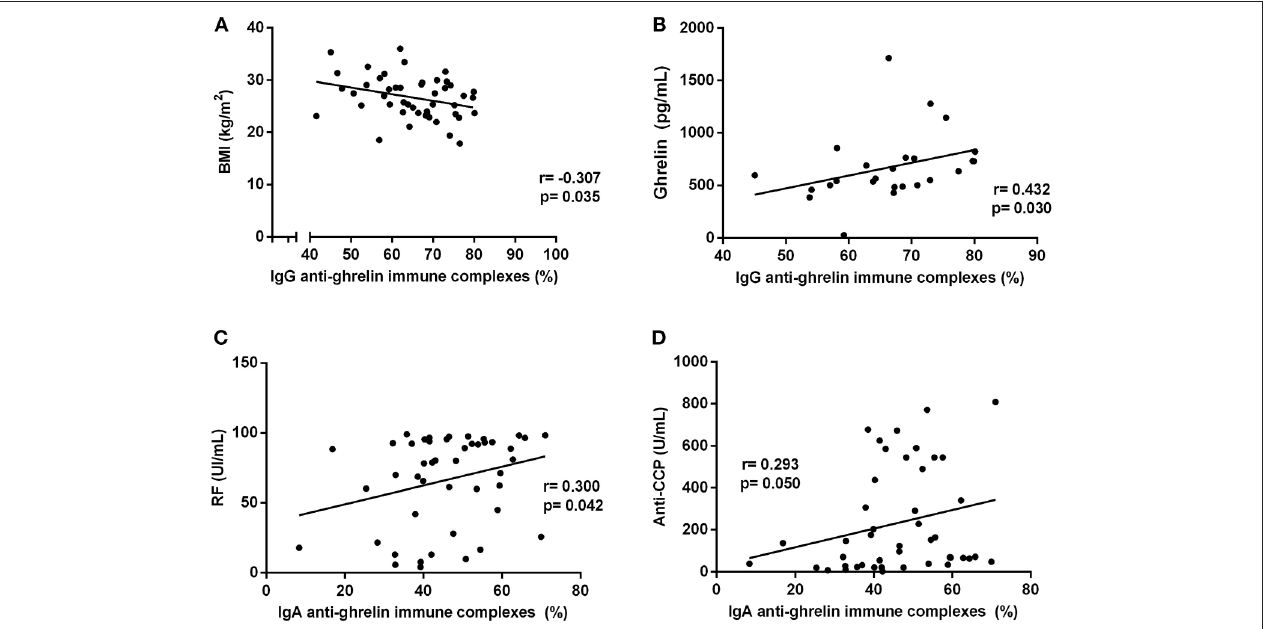
FIGURE 2 | Correlations analysis of IgG and IgA anti-ghrelin immune complexes percentage with clinical and metabolic parameters in rheumatoid arthritis patients. (A) Correlation between IgG immune complexes % and BMI. (B) Correlation between IgG immune complexes % and ghrelin levels. (C) Correlation between IgA immune complexes % and RF. (D) Correlation between IgA immune complexes % and anti-CCP antibodies. BMI, body mass index; RF, rheumatoid factor; Anti-CCP, anti-cyclic citrullinated peptide antibodies. R, Spearman’s or Pearson’s coefficient, as appropriate. Statistical significance was considered at p ≤ 0.05.